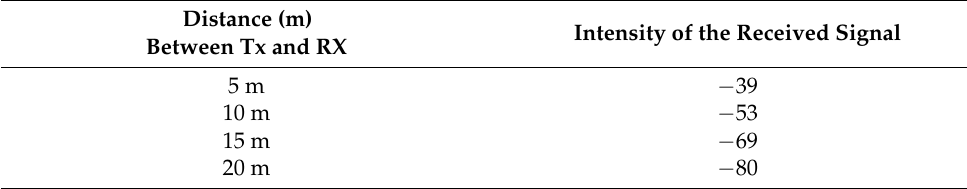
Table 8. Zigbee test